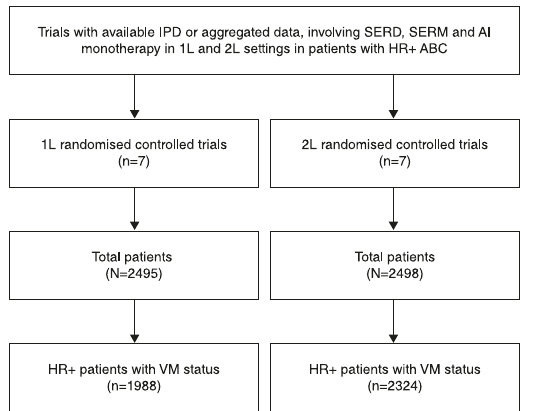
Fig. 1 Study-selection fl ow chart. 1 L fi rst line, 2 L second line, AI aromatase inhibitor, BC breast cancer, HR + hormone receptor- positive, IPD individual patient data, n number of patients, SERD selective estrogen receptor degrader, SERM selective estrogen receptor modulator, VM visceral